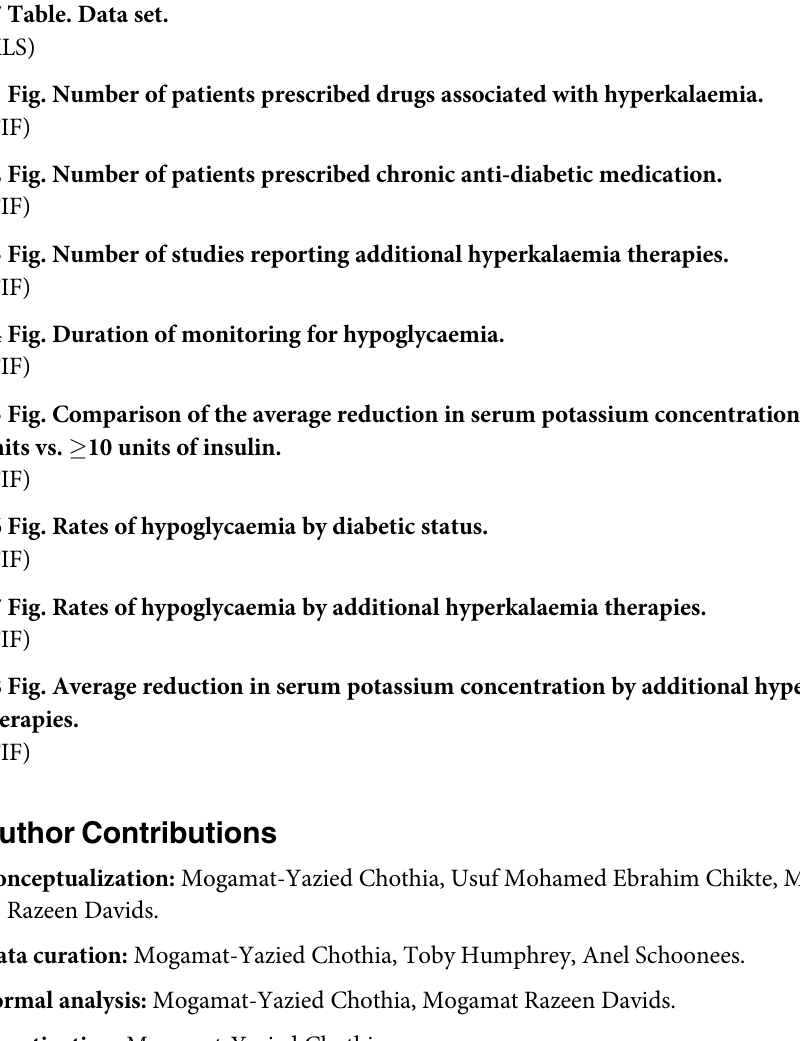
S5 Table. Included systematic reviews. S6 Table. Predictors of hypoglycaemia by primary studies that performed regression anal- ysis. All predictors included were statistically significant, P < 0.05. S7 Table. Data set. S1 Fig. Number of patients prescribed drugs associated with hyperkalaemia. S2 Fig. Number of patients prescribed chronic anti-diabetic medication. S3 Fig. Number of studies reporting additional hyperkalaemia therapies. S4 Fig. Duration of monitoring for hypoglycaemia. S5 Fig. Comparison of the average reduction in serum potassium concentration with < 10 units vs. � 10 units of insulin. S6 Fig. Rates of hypoglycaemia by diabetic status. S7 Fig. Rates of hypoglycaemia by additional hyperkalaemia therapies. S8 Fig. Average reduction in serum potassium concentration by additional hyperkalaemia